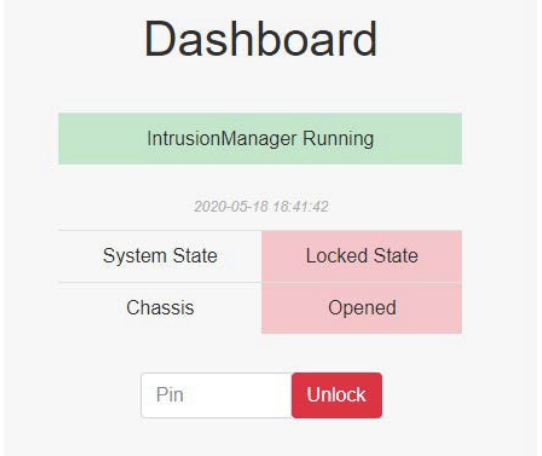
Figure 28. Locked state.